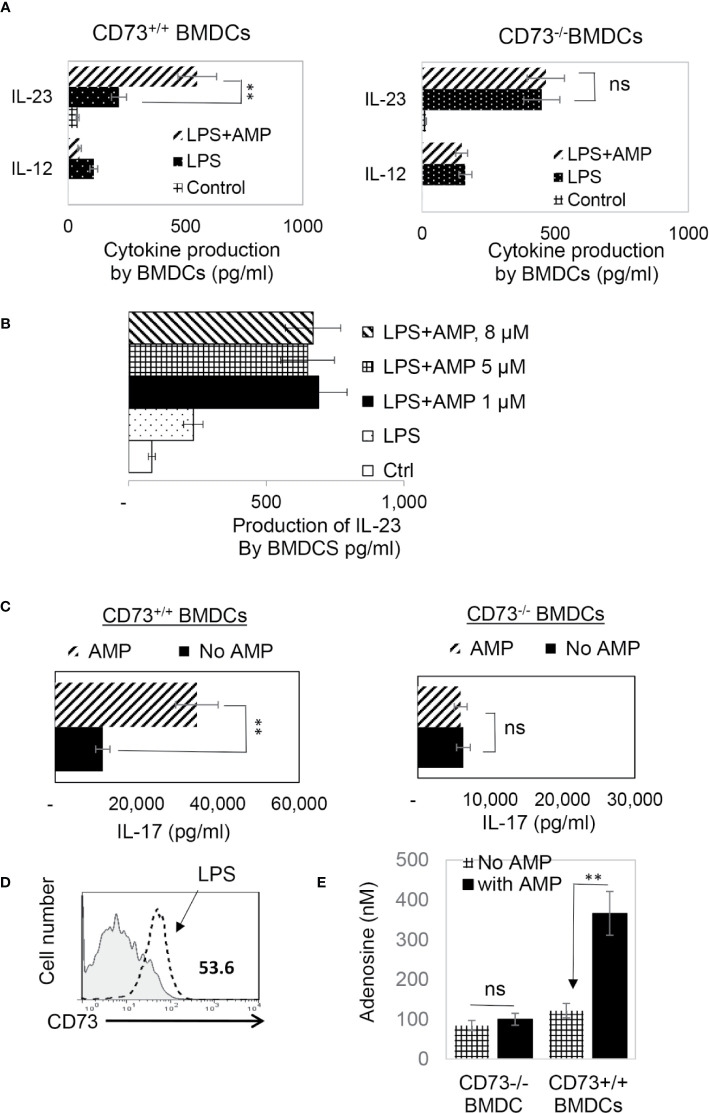
In response to AMP LPS-treated CD73+/+, but not CD73−/−, BMDCs produced greater amounts of IL-23 and acquired greater Th17 stimulating activity (A). ELISA assays for IL-12 and IL-23 production by CD73+/+ and CD73−/− BMDCs. 48h stimulated culture supernatants of CD73+/+ and CD73−/− BMDCs were assessed for IL-12 and IL-23, after being stimulated with LPS or LPS plus AMP. The control BMDCs remained untreated. The data are from one single experiment and are representative of those obtained in three independent experiments. Values are expressed as mean ± SEM (n = 6). **p <0.05. ns, not significant (B). ELISA assay test AMP doses ranging from 1 to 8 µM showed no apparent dose dependent effect. The experimental setting was the same as
Figure 3A

(C). ELISA assays for IL-17 production by responder T cells after 48h stimulation by the immunizing antigen and CD73+/+ or CD73−/− BMDCs. The data are from one single experiment and are representative of those obtained in three independent experiments (D). LPS exposed BMDCs expressed increased amount of CD73. BMDCs were treated (dotted line) or untreated with a small dose of LPS (50 ng/ml) before stained with anti-CD73 mAB followed by FACS analysis (E). Adenosine assay. Adenosine in the supernatants of cultured BMDCs was measured by an Adenosine Assay Kit (Fluorometric) after the CD73+/+ or CD73−/− BMDCs were treated with LPS (100 ng/ml) with or with additional treatment of AMP (1 μM). ns, not significant.